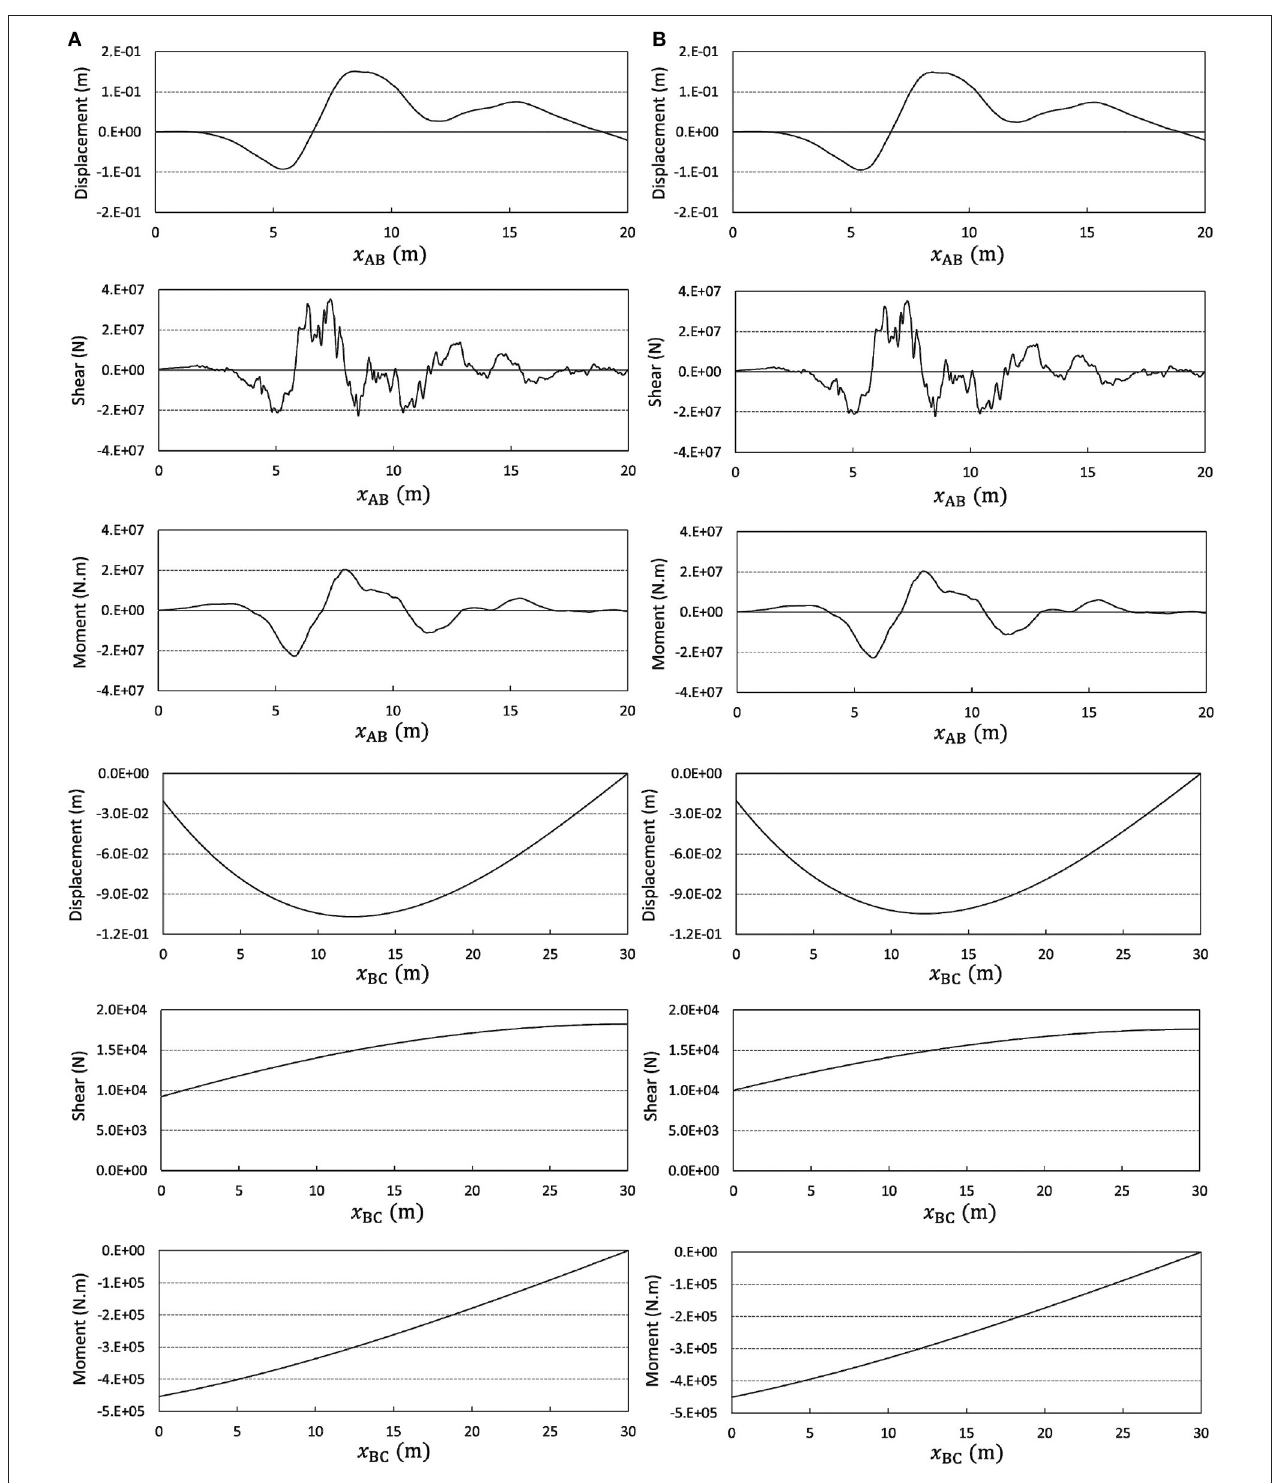
FIGURE 6 | Responses of the second example considering large displacements and obtained from analysis with elements sized (A) f 1 x and (B) 3 f 1 x .